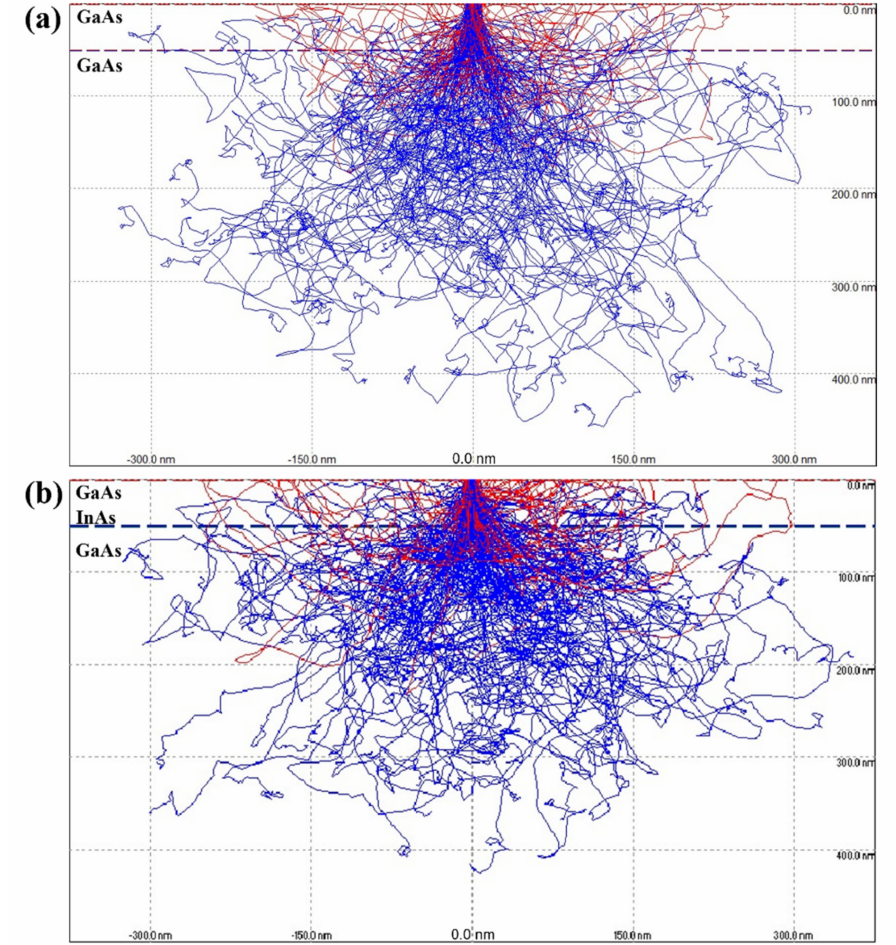
Figure 4. Cross-sectional images of simulated trajectories of backscattered electrons (red) and sec- ondary electrons (blue) in samples ( a ) without any InAs and ( b ) with a 1.0 ML InAs layer. The incident energy of electrons is selected to be 10